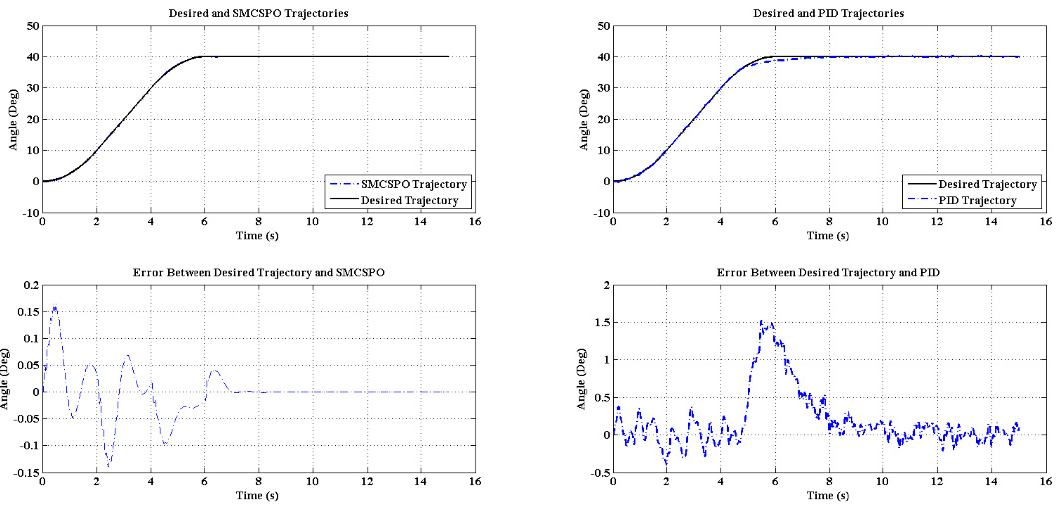
Figure 9. Pictorial view of visual feedback.